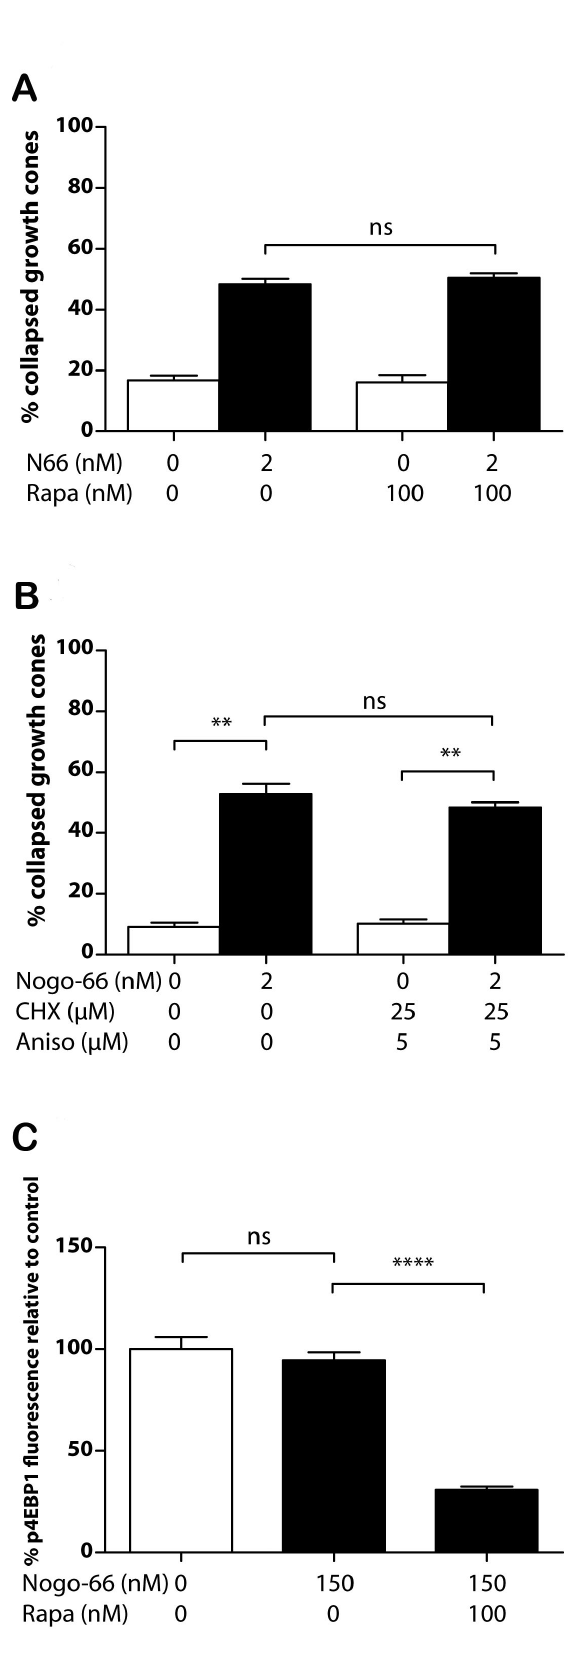
Figure 4. Dependence of Nogo-66-induced growth cone collapse on protein synthesis. A/ Nogo-66-induced collapse remains